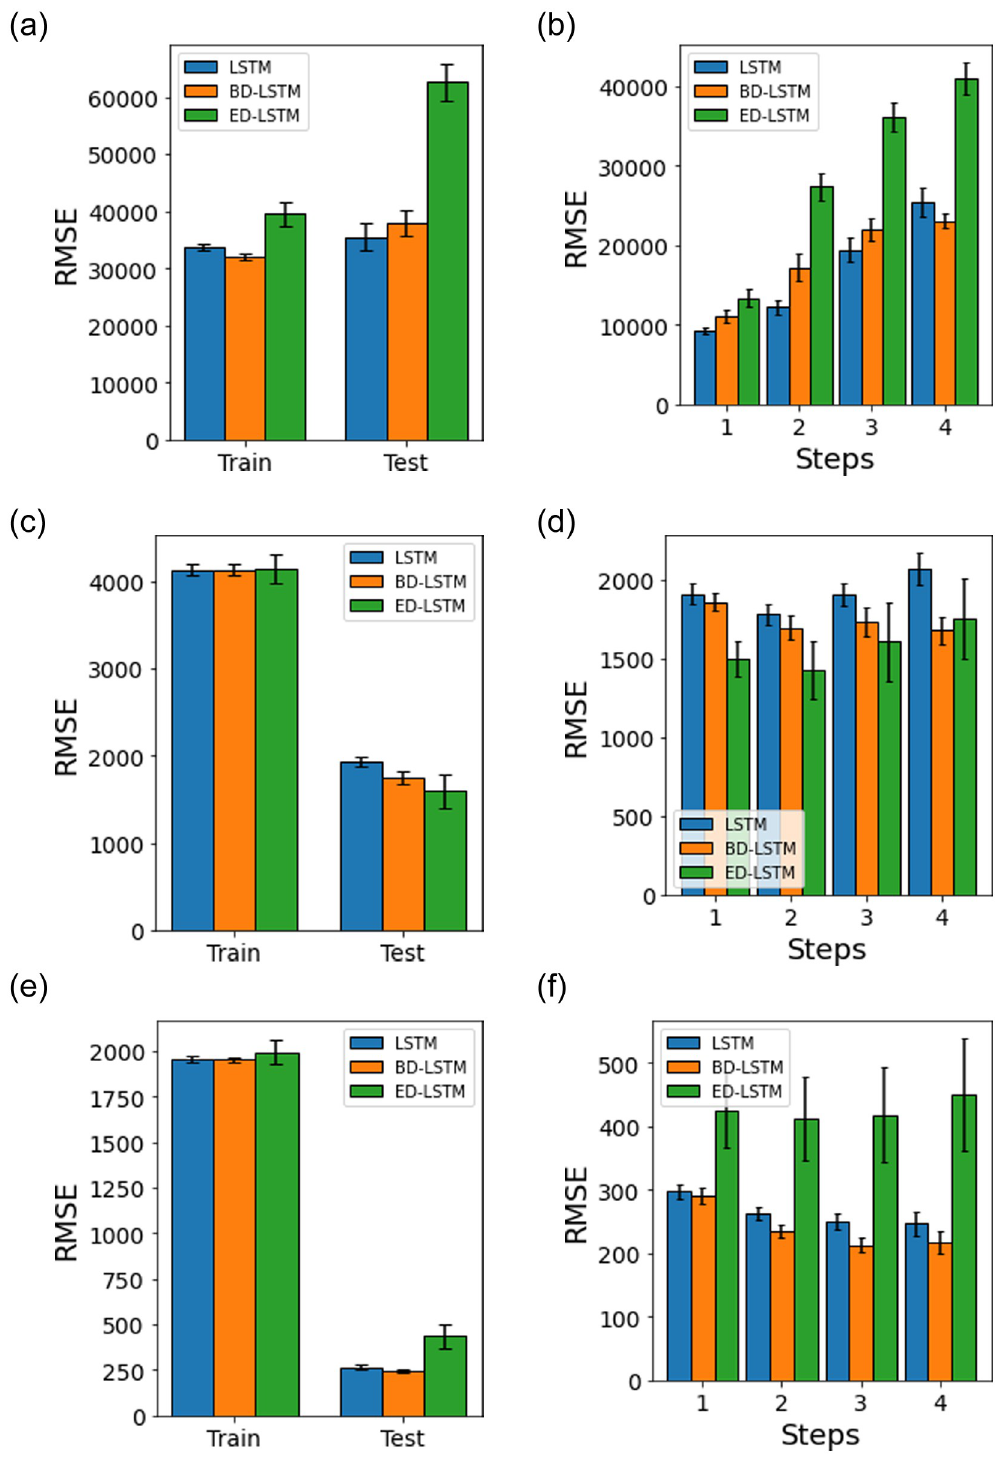
Fig 7. Univariate LSTM, BD-LSTM and ED-LSTM model performance accuracy (RMSE) with a static-split for the train and test datasets, and test prediction horizons (steps). The error bars represent the mean and 95% confidence interval for 30 experiment